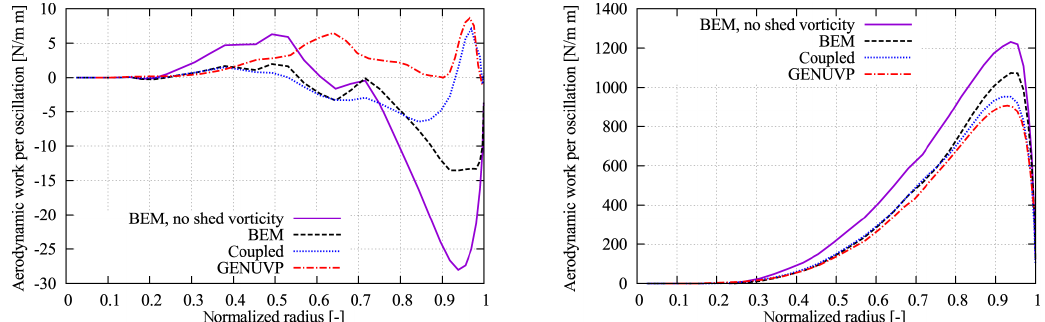
Figure 19. Aerodynamic work per oscillation of first edge motion at 8ms − 1 (left) and 25ms − 1 (right) wind speed with an amplitude of 1.0m.